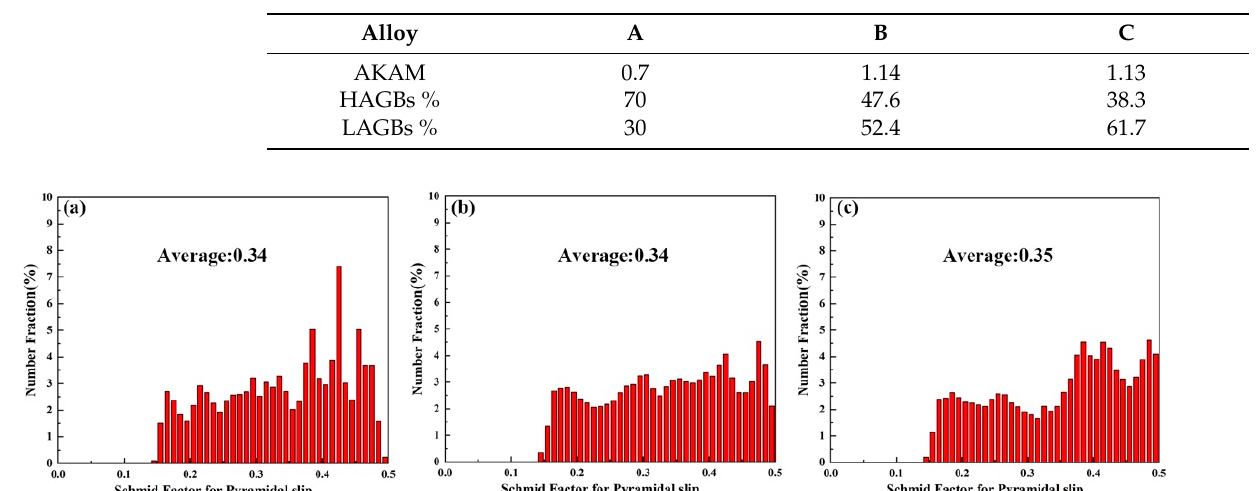
Figure 15. The pyramidal <c + a> slip SF distribution of three alloys, ( a ) Alloy A, ( b ) Alloy B, ( c ) Alloy C.